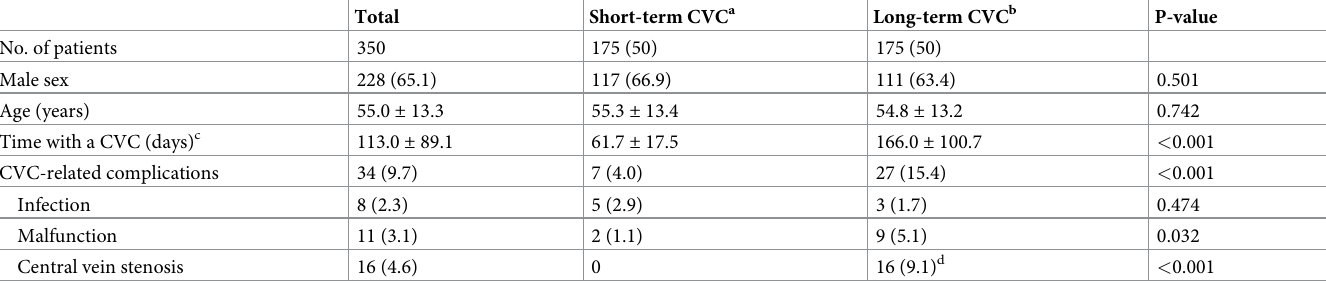
Table 6. Baseline demographics and clinical characteristics of the patients initiated HD with a CVC according to the duration of CVC use.